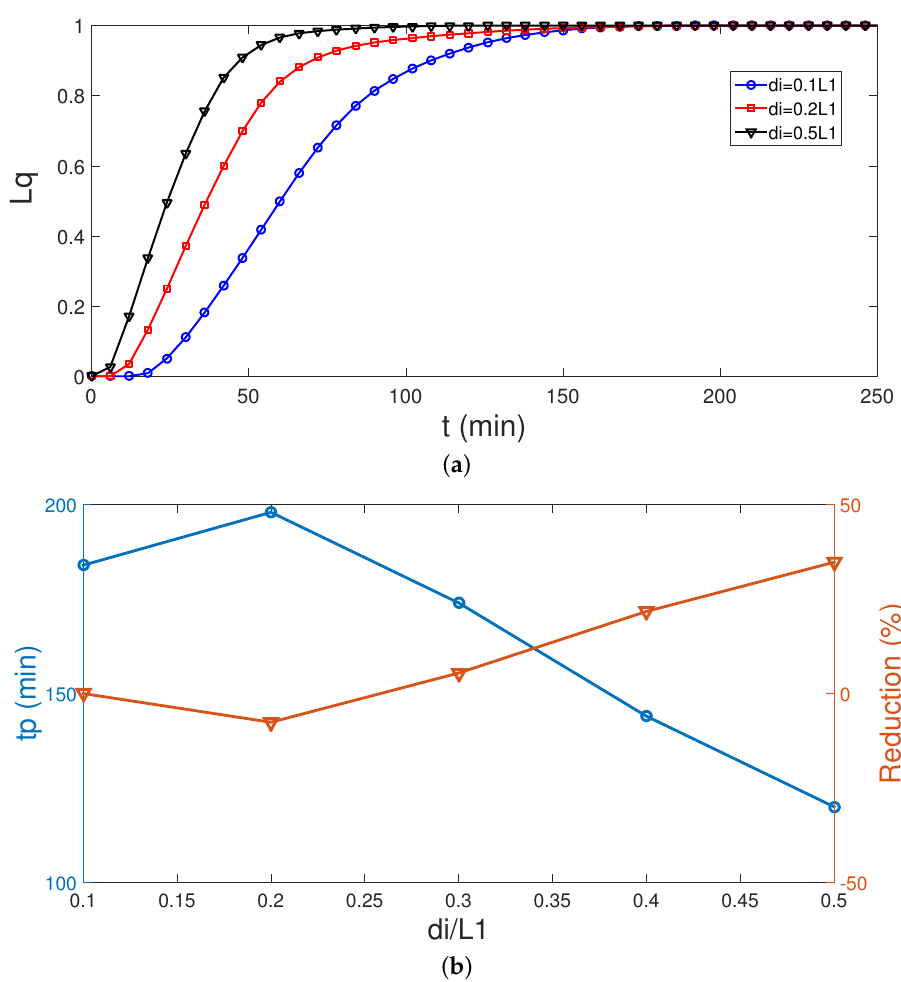
Figure 12. Impacts of port size on the time evolution of average Lq ( a ) and complete phase transition time (tp in minutes) ( b ) (Re = 300, Rew = 500, L 0 = 0.6 L 1, yp = 0.1 H, and NC =